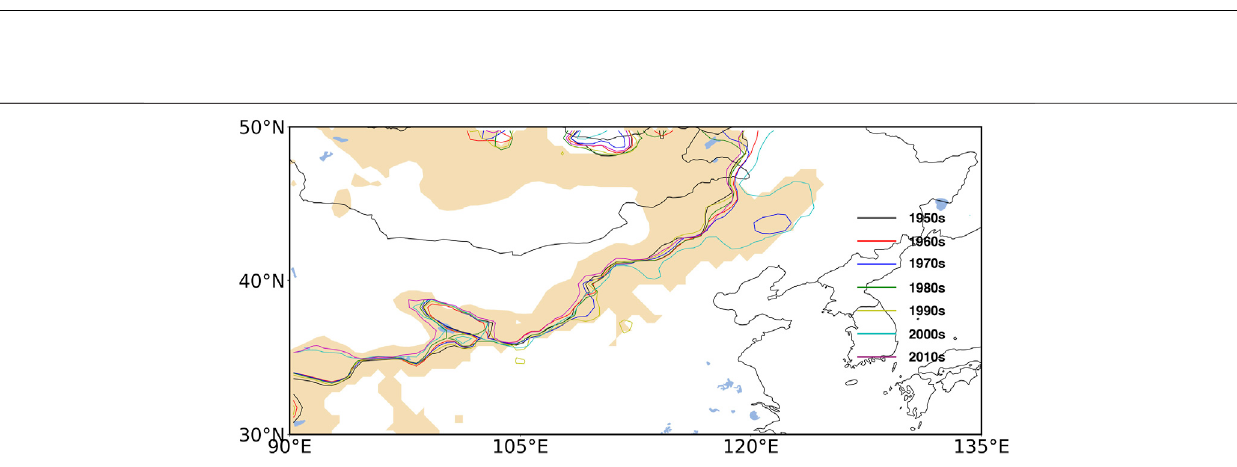
Frontiers in Earth Science |